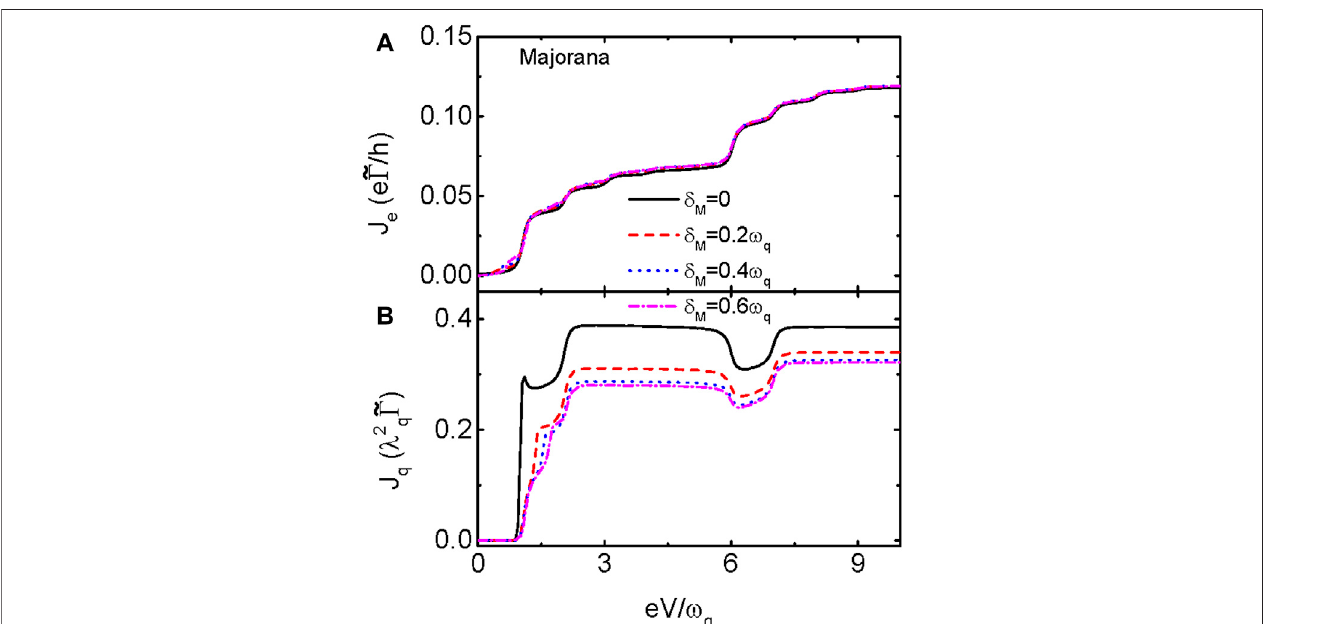
Frontiers in Physics |